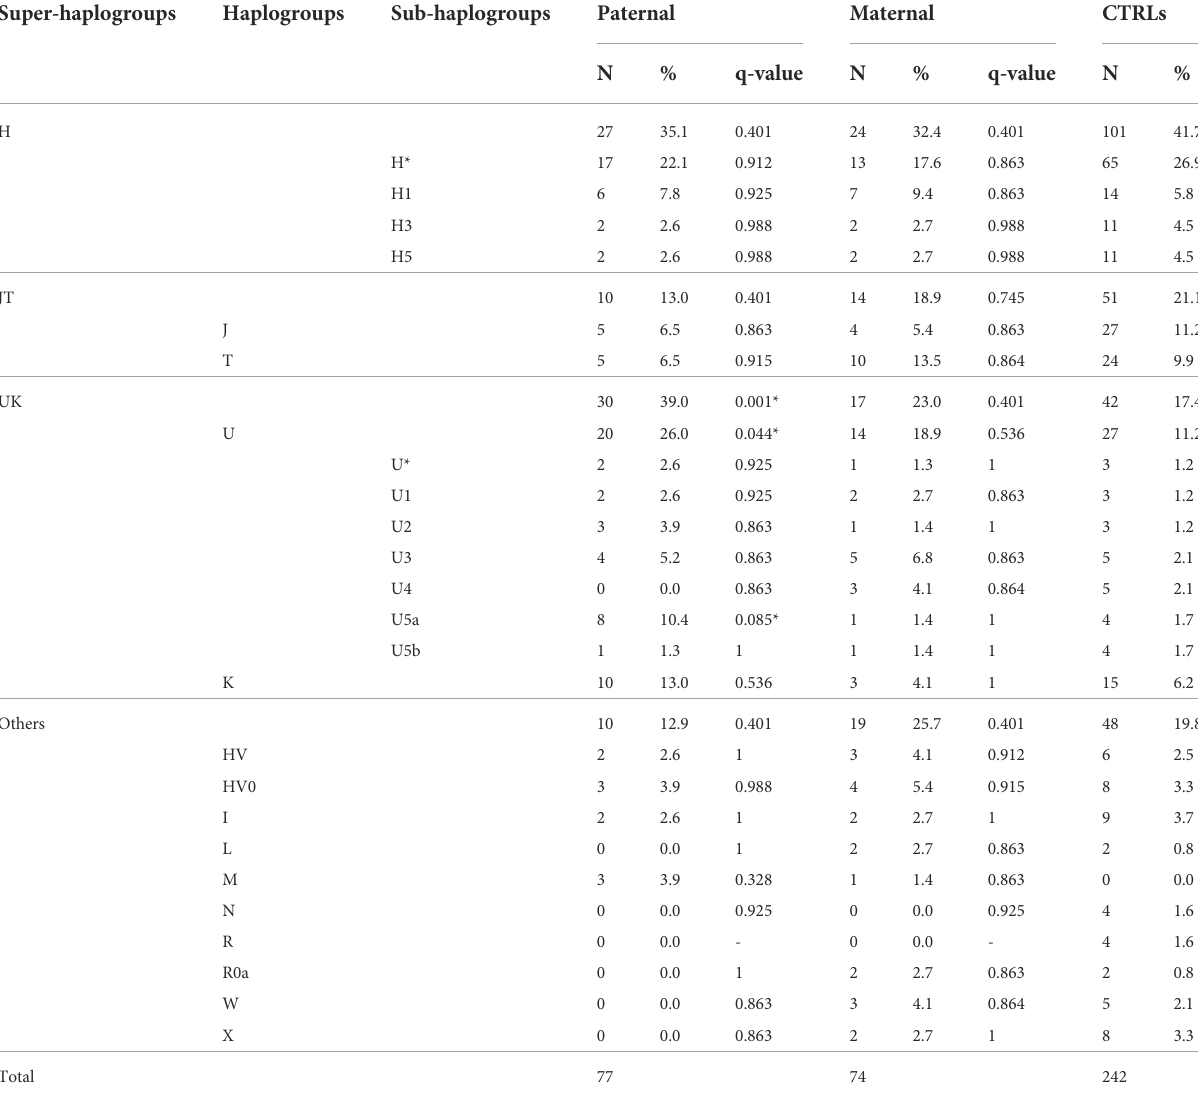
TABLE 1 Mitochondrial haplogroups distribution in the Italian ASD paternal and maternal lines from the test cohort, compared to Italian healthy controls. Super-haplogroups